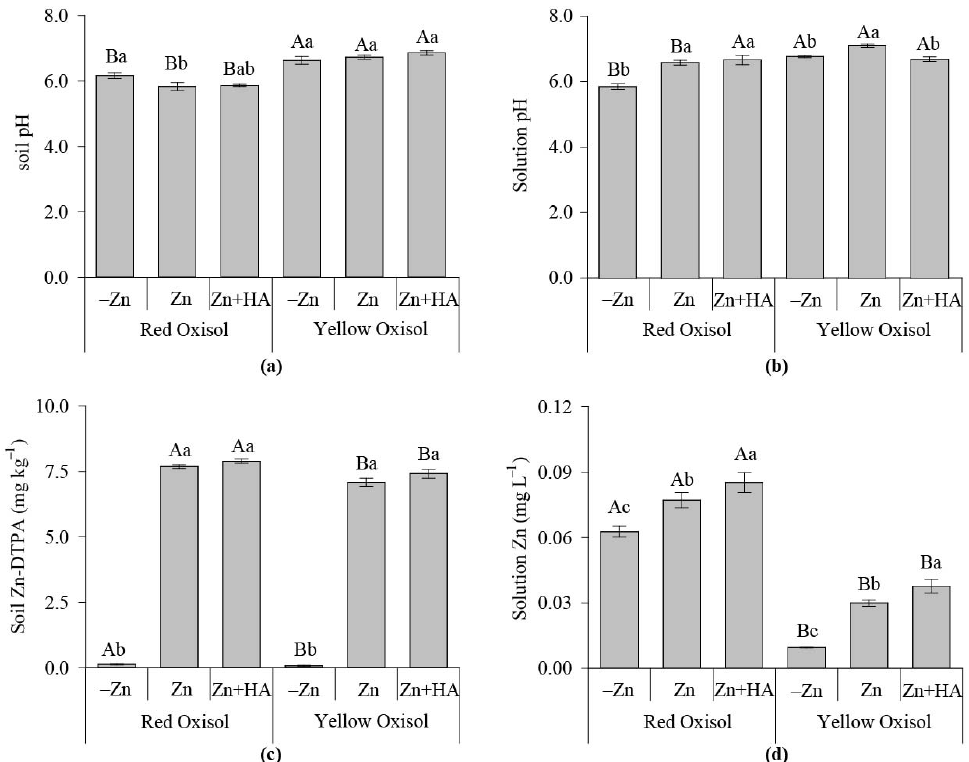
Figure 3. Effect of Zn fertilization and humic acid (HA) on soil pH and available DTPA Zn in contrasting Oxisols cultivated with brachiaria. Soil pH ( a ); soil solution pH ( b ); Zn available through the DTPA soil test ( c ); Zn in soil solution ( d ). Bars followed by the same capital letter mean that the soil attributes did not differ in terms of the Zn fertilization strategies adopted, according to the Tukey test ( p < 0.05). Bars followed by the same lowercase letter mean that the soil attribute means do not differ regarding response to Zn fertilization strategies within each soil type, according to the Tukey test ( p < 0.05). − Zn: no-Zn fertilization; Zn: Zn fertilization; Zn + HA: Zn fertilization combined with HA application.